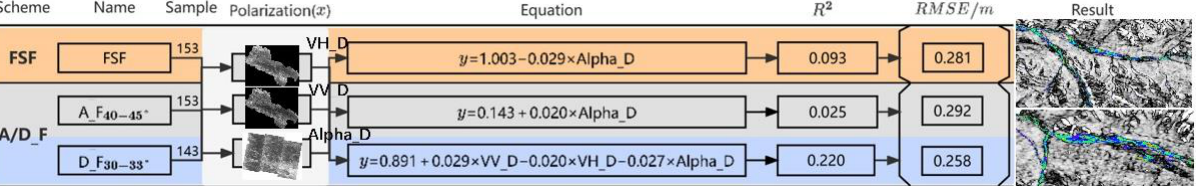
Figure 12. Comparison between the measured and simulated ice thicknesses in the Binggou River, with red dots indicating the univariate regression results and the black dots indicating the stepwise regression results. The red boxes indicate the univariate regression-simulated metrics, while the black boxes indicate the stepwise regression-simulated metrics. The panels are lettered a through f from left to right, top to bottom. ( a ) FSF; ( b ) TSF_Jan; ( c ) TSF_Feb–Apr; ( d ) A_F 40–45° ; ( e ) D_F 30–33° ; ( f ) D_F 38–43° . In addition, the high elevation of the Binggou River region (mean elevation of 3800 m) and the fact that most of the area is obscured by mountains cause the Sentinel-1 data with a 10 m spatial resolution to exhibit a less satisfactory performance. Hence, the results obtained for the Binggou River are relatively poor compared to those acquired for the Babao River, as the topography of the Binggou River is more complex, the channel is nar- rower, the ice is thicker, and the relationship with radar polarization parameters is more complex. However, with the support of publicly available radar data, it was found that some correlations could be found with the polarization parameters under the influence of topography, and some of the fitting equation results were acceptable.